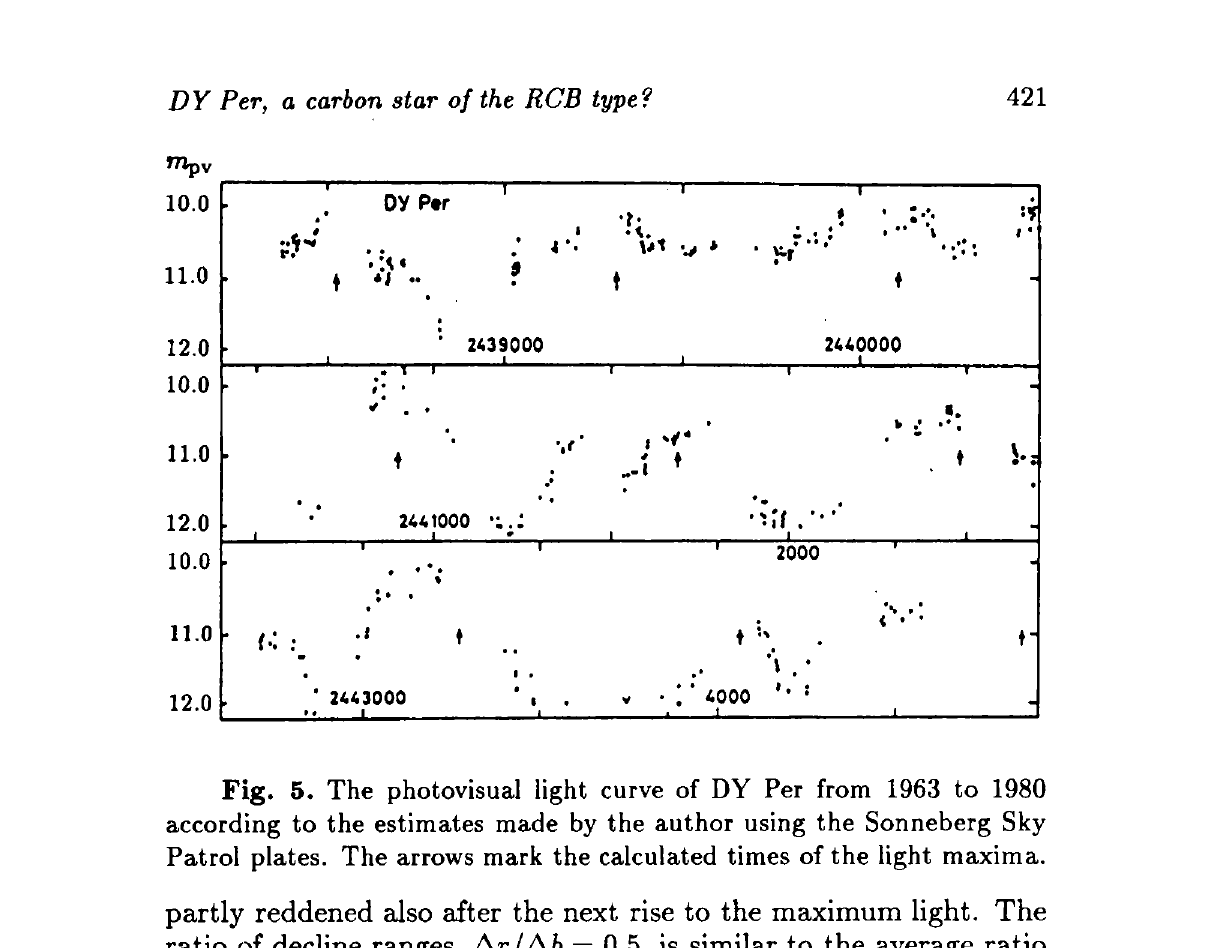
Fig. 5. The photovisual light curve of DY Per from 1963 to 1980 according to the estimates made by the author using the Sonneberg Sky Patrol plates. The arrows mark the calculated times of the light